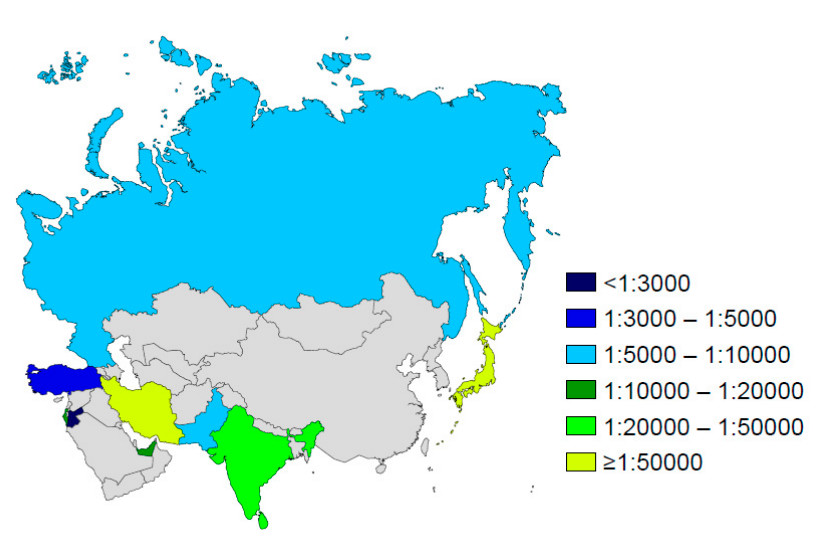
Figure 6. Incidence of cystic fibrosis in Asia.